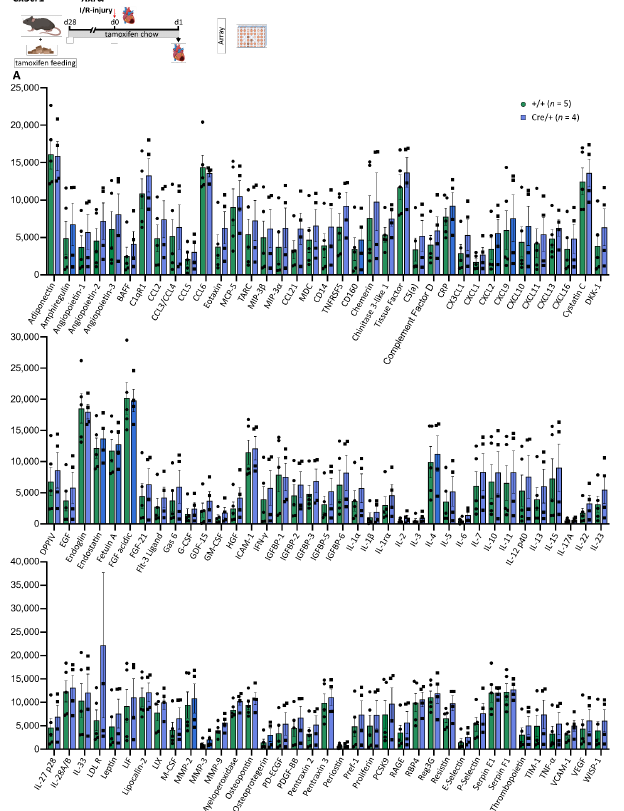
Figure 6. A Reduced expression of Rxr α in myeloid cells has no impact on cardiac cytokine and